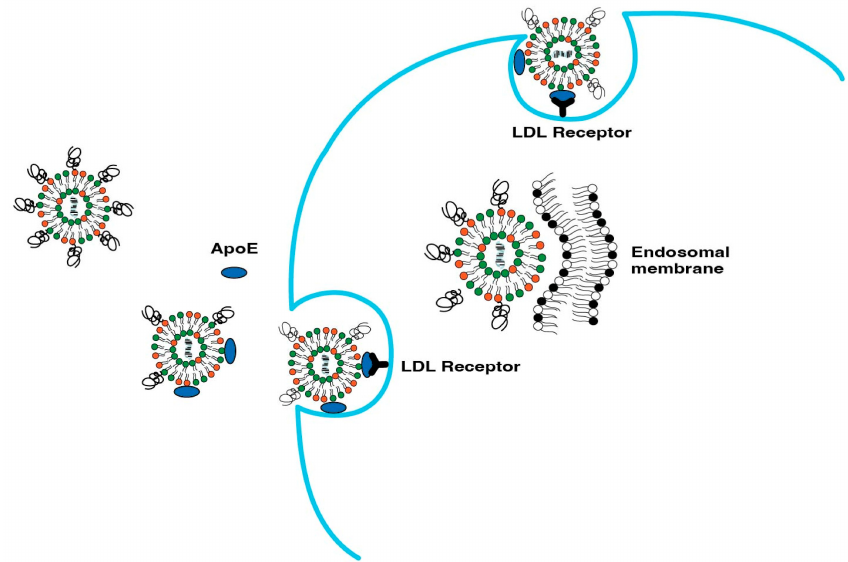
Figure 5. ApoE-mediated uptake of LNPs in